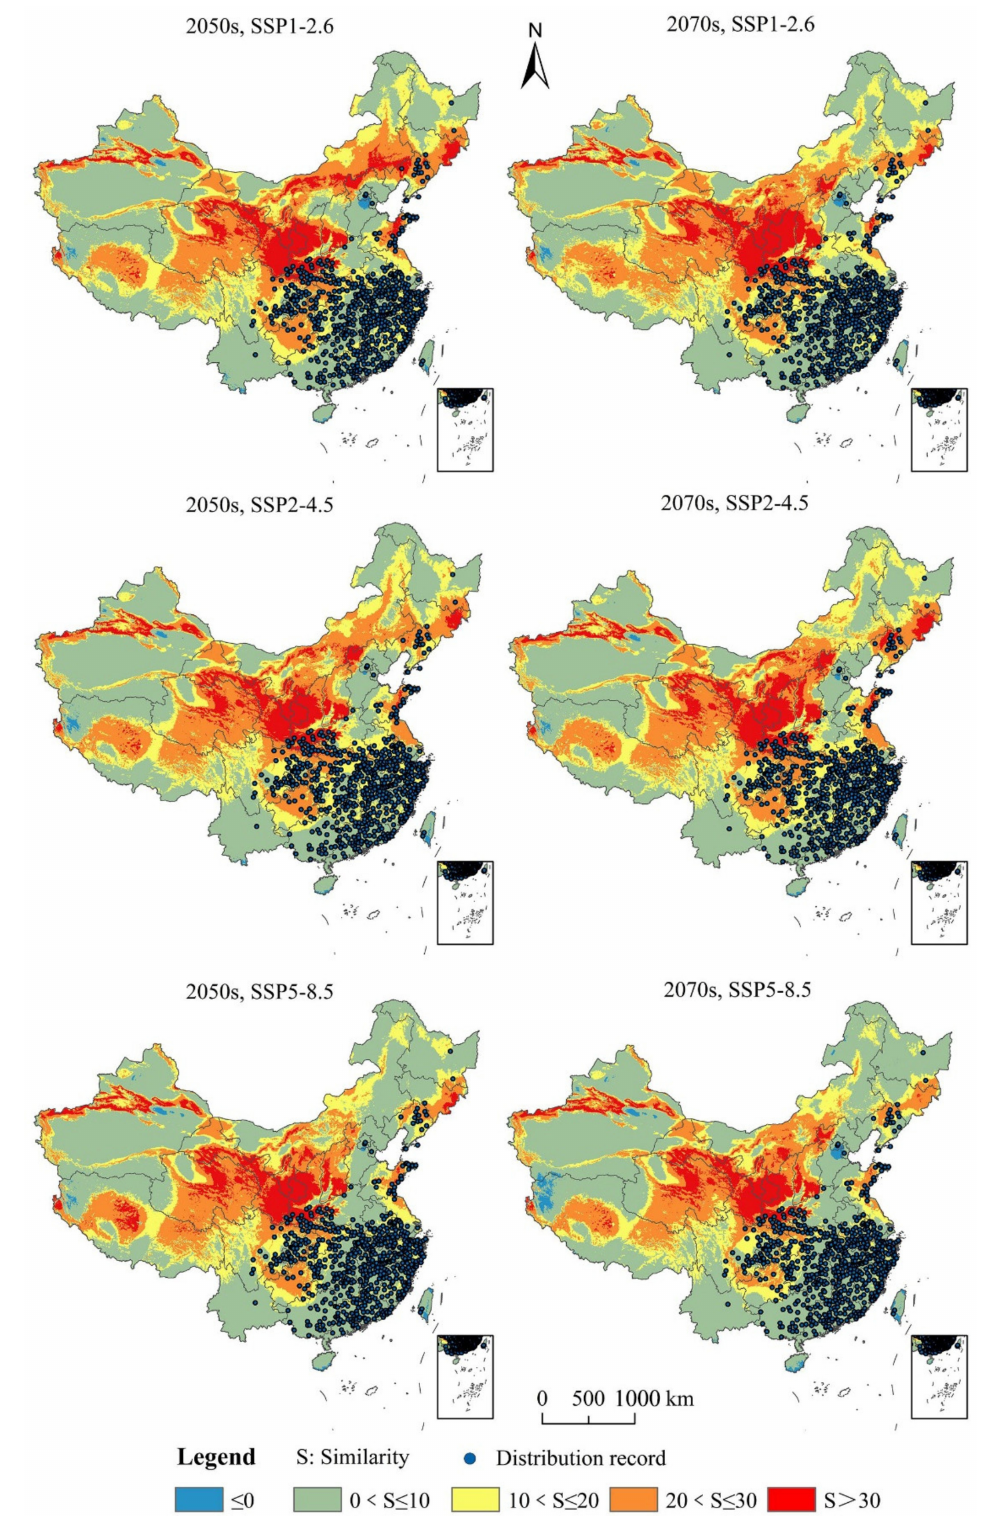
Figure 7. Assessment of the multivariate environmental similarity surface (MESS) of potential pine wilt disease distribution under future climate change